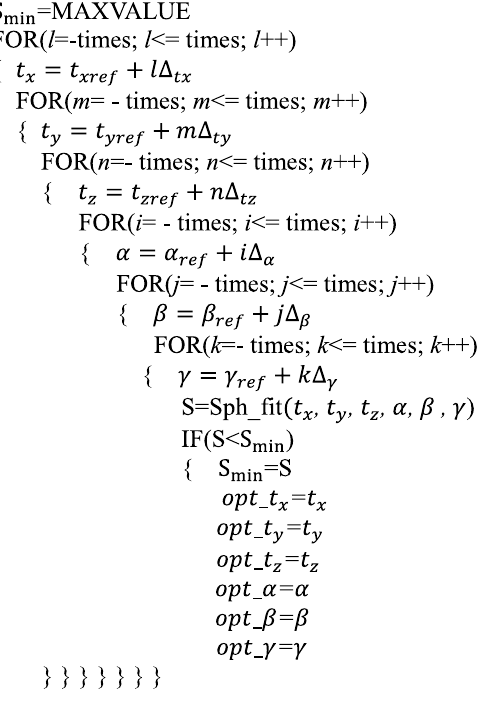
Table 1 Steps of the six parameters in the searching algorithm (cid:31) tx , (cid:31) ty , (cid:31) tz